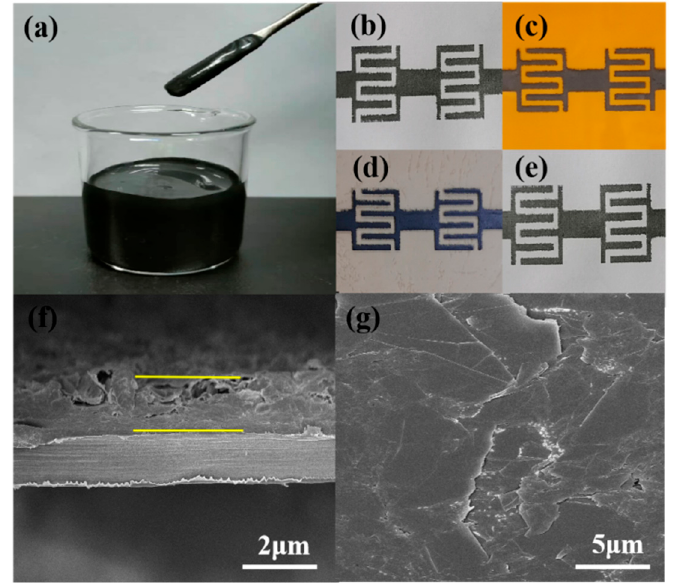
Figure 5. ( a ) Graphene/PVA-g-PANI ink; graphene/PVA-g-PANI ink at different substrates: ( b ) BOPP, ( c ) PI, ( d ) PET, and ( e ) A4 paper; SEM images of the film prepared with graphene/PVA-g- PANI ink: ( f ) section and ( g ) surface images.